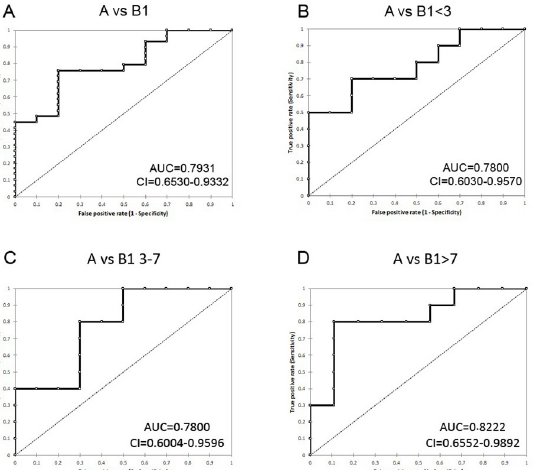
Fig 2. ROC curves for miR-30b-5p. Discrimination capacity between group A and group B1 (A), group A and group B1 < 3 (B), group A and group B1 3–7 (C), and group A and B1 > 7 (D). MiR-30b-5p can discriminate between healthy and asymptomatic MMVD-affected dogs (stage B1).